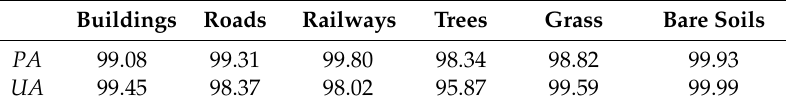
Table 2. PA and UA of each class of Zurich dataset